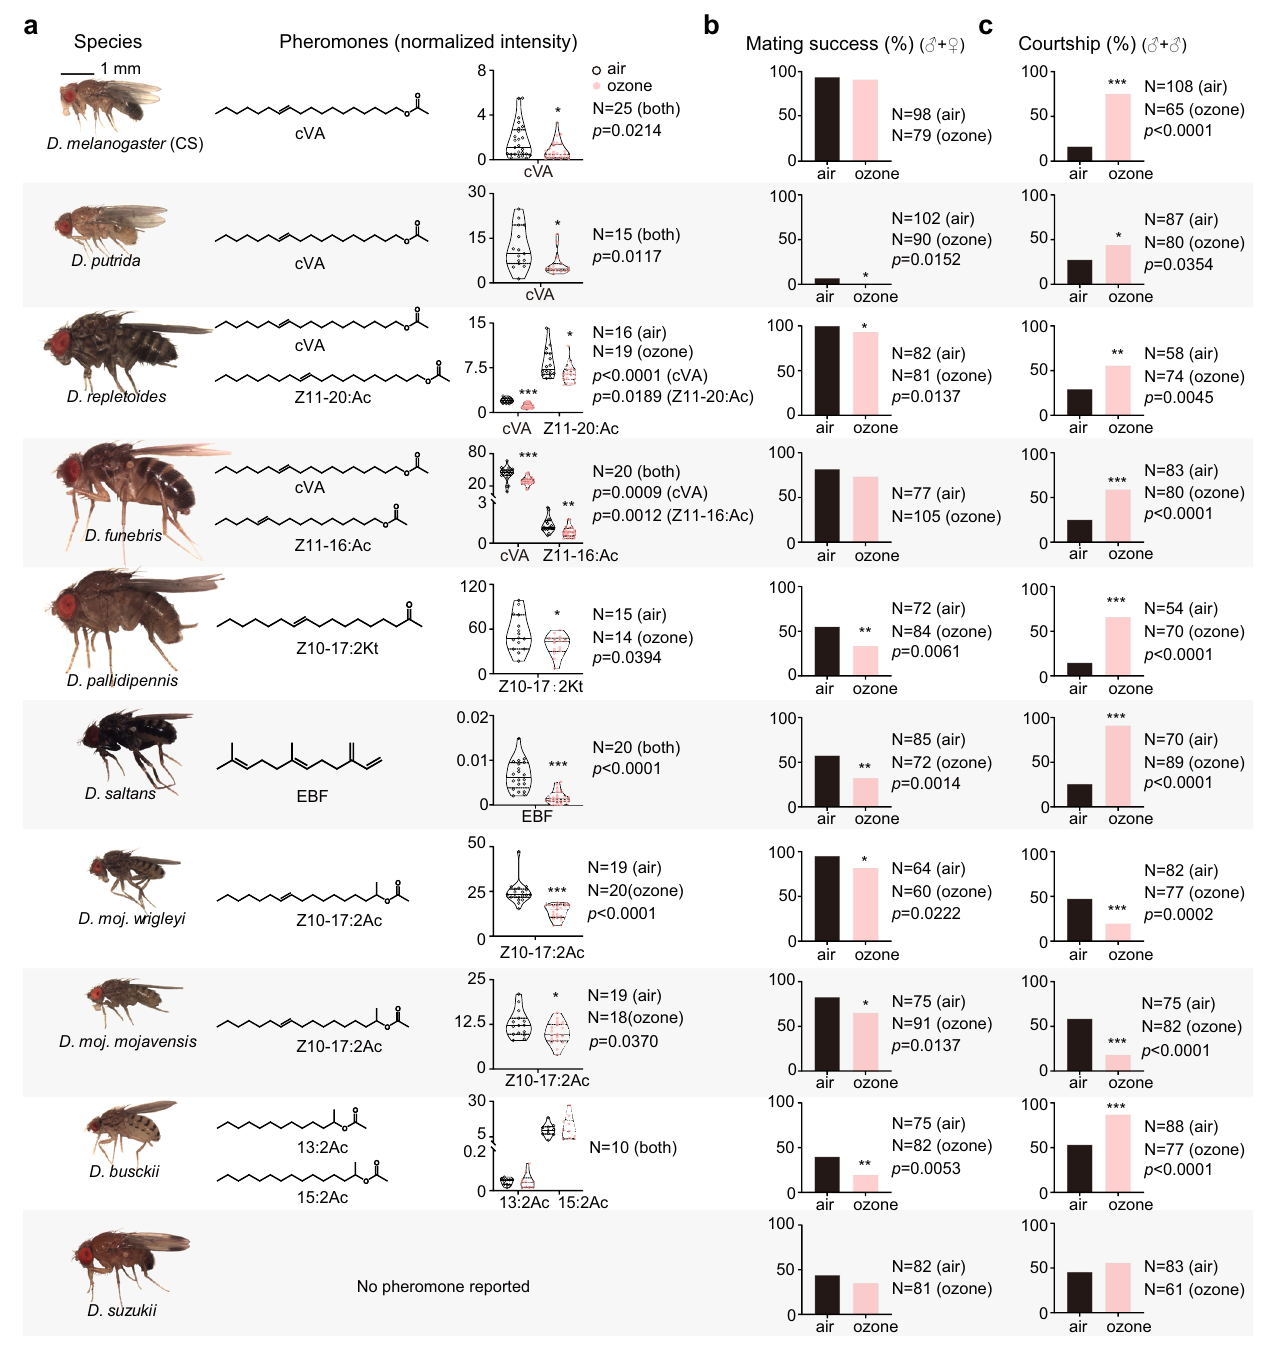
Fig. 3 | Effectsofozone onmale-speci fi c compounds and sexualbehaviorof10 drosophilidspecies.a Datadepictnormalizedpeakareasofpheromonesinozone exposed and control fl ies (Two-tailed unpaired t -test; * p <0.05; ** p <0.01; *** p <0.001). b , c Effect on mating success (i.e., percentage of